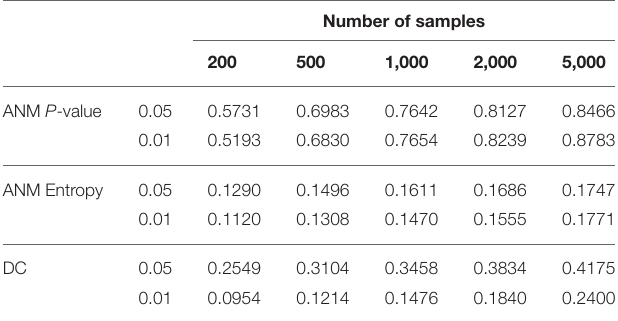
TABLE 4 | Power of three statistical methods for testing causation in the presence of both association and